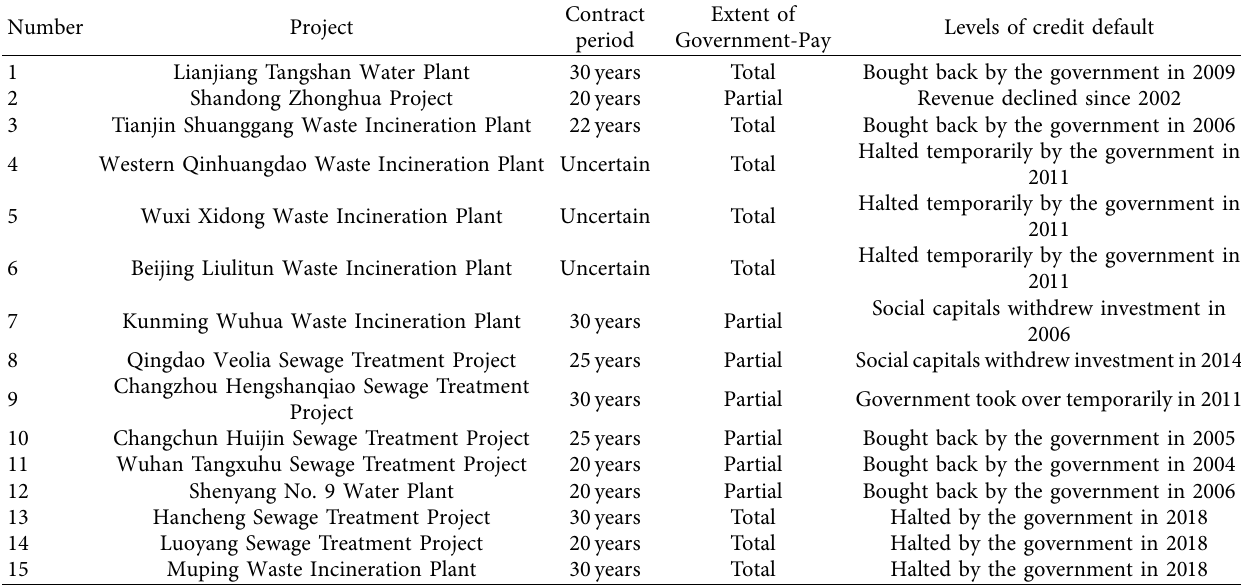
Table 2: General information on 15 cases from ecological construction.